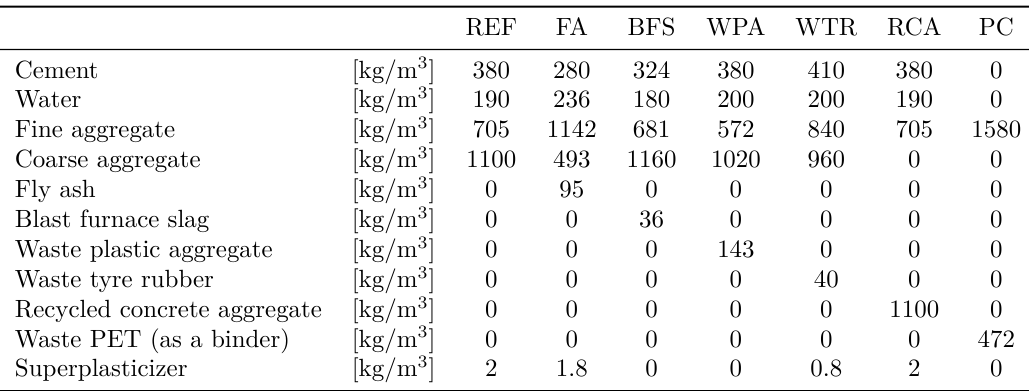
Table 1. The composition of the concrete